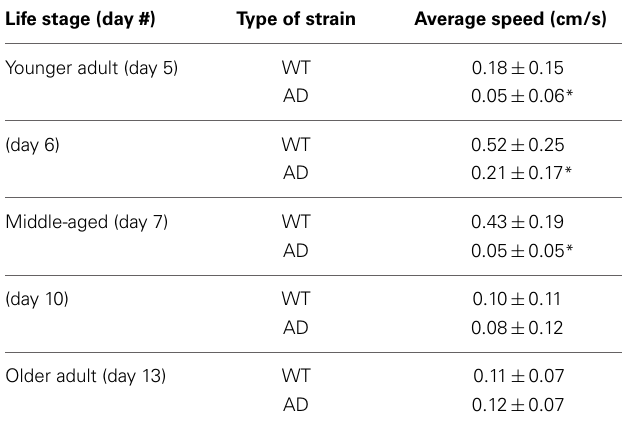
Table 1 | Locomotion speed (mean ± standard deviation) as assessed by MWT analysis for various stages in the life cycle ( * p < 0 .